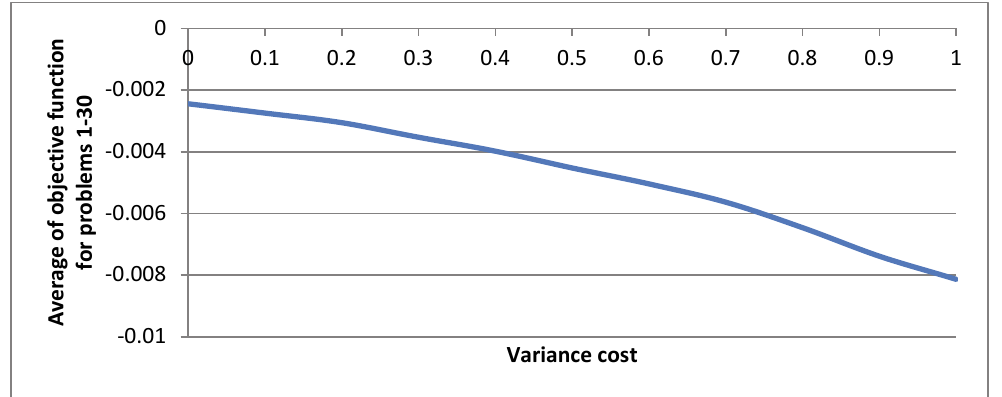
Fig. 4. Sensitivity analysis for the variance cost parameter.